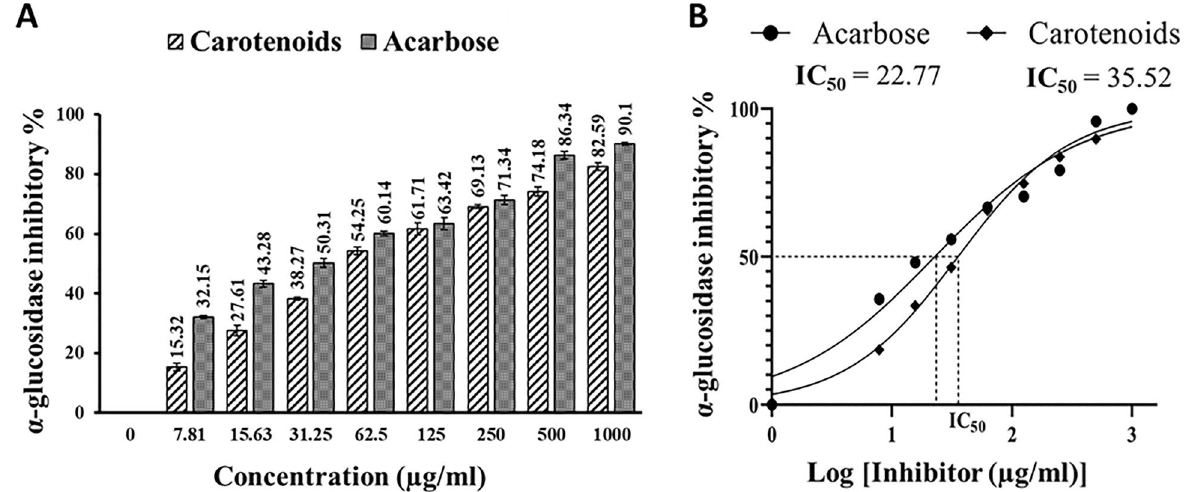
Figure 13. ( A ) In vitro α-glucosidase inhibitory effect of Kocuria sp. RAM1 carotenoids vs. acarbose (positive control) at different concentrations. ( B ) IC 50 estimations. The data represent the mean ± SD (n =